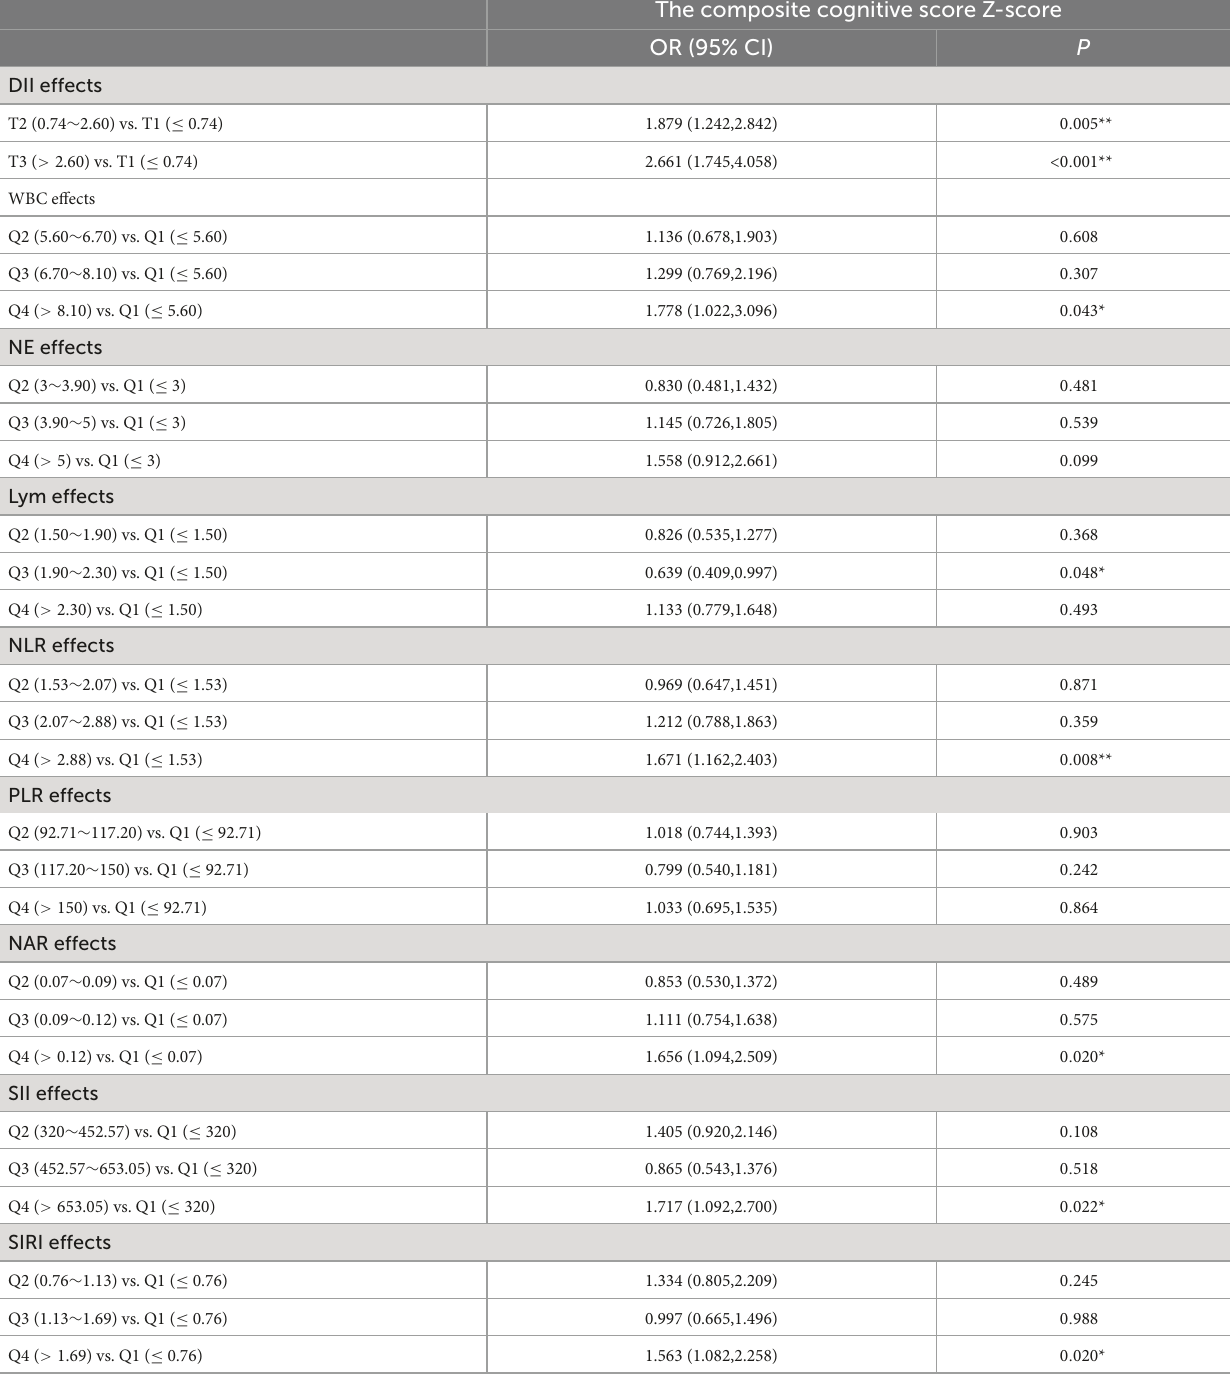
TABLE 5 The effect of dietary inflammatory index and blood inflammation indicators on cognitive function was analyzed by logistic regression. The composite cognitive score Z-score OR (95% CI)